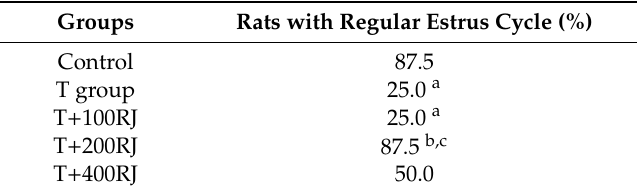
Table 4. Rats with regular estrus cycle in all experimental groups.